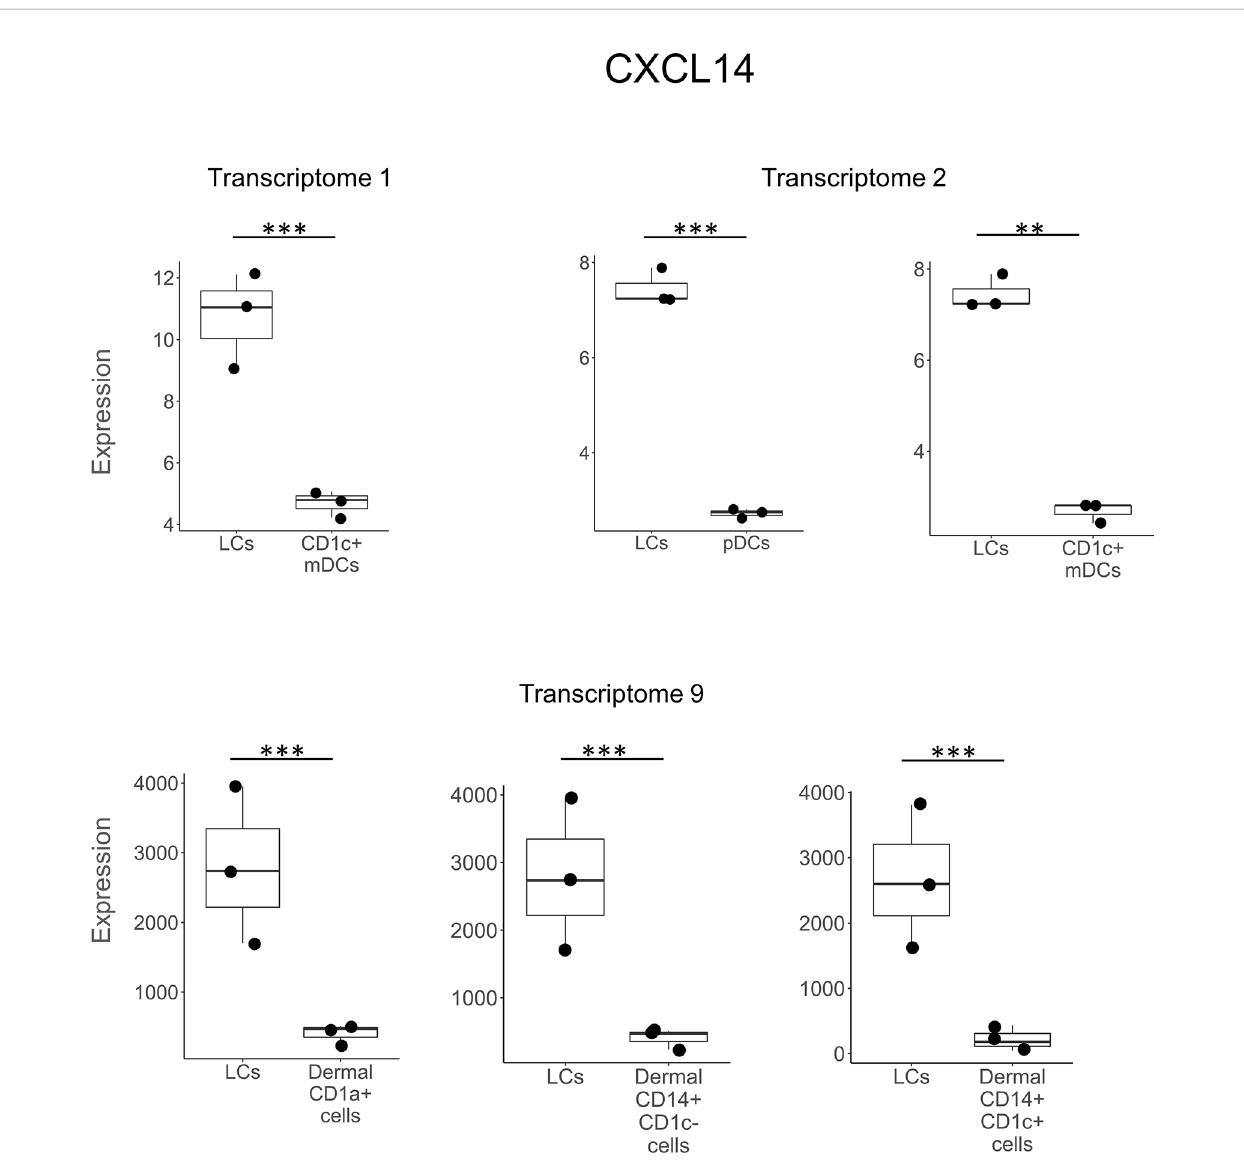
FIGURE 3 | CXCL14 expression in LCs vs other DC subtypes. CXCL14 was preferentially expressed in LCs vs other DC types in 3 out of the 9 transcriptomes in a total of 6 different instances. **p < 0.01, ***p <